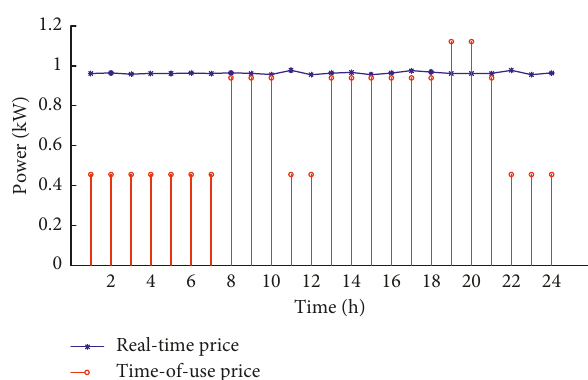
Figure 6: Comparison of two types of electricity